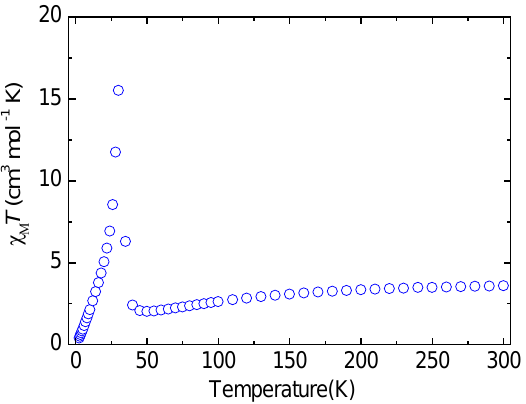
Figure 5. Plot of χ M T vs. T of Compound 1 in an applied field of 1 kOe from 2–300 K.